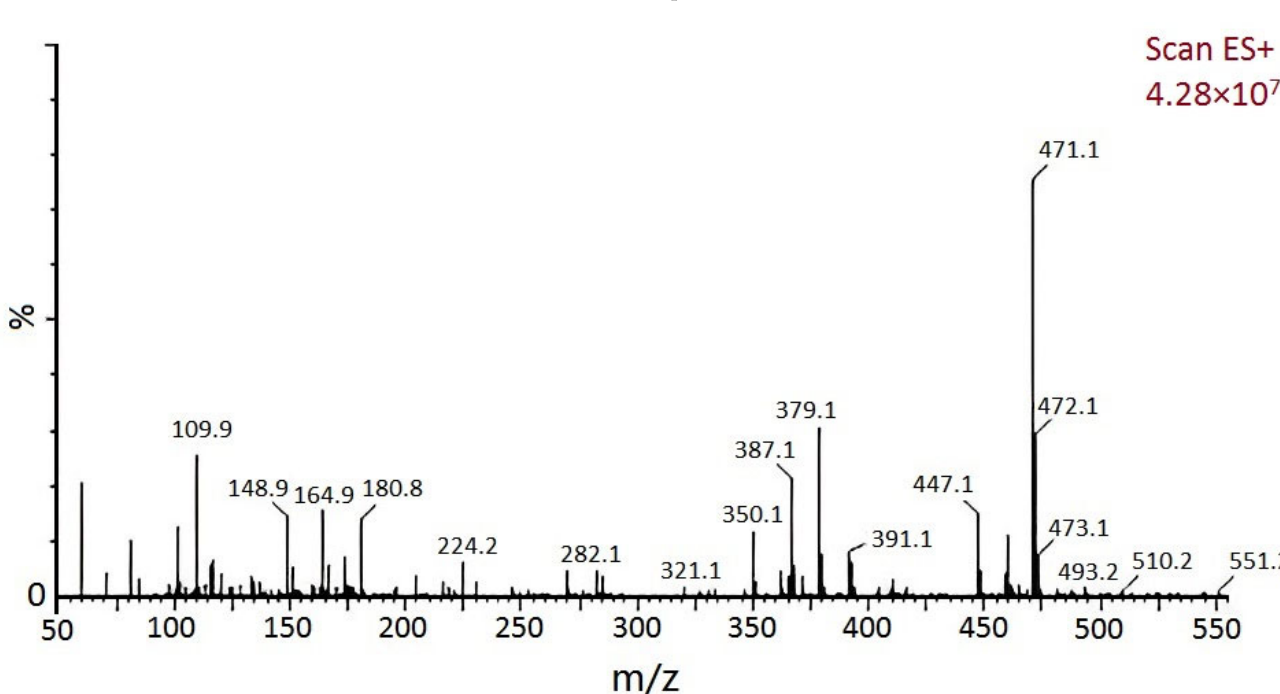
Figure 12. GPC of benzoxazine (bisphenol A).